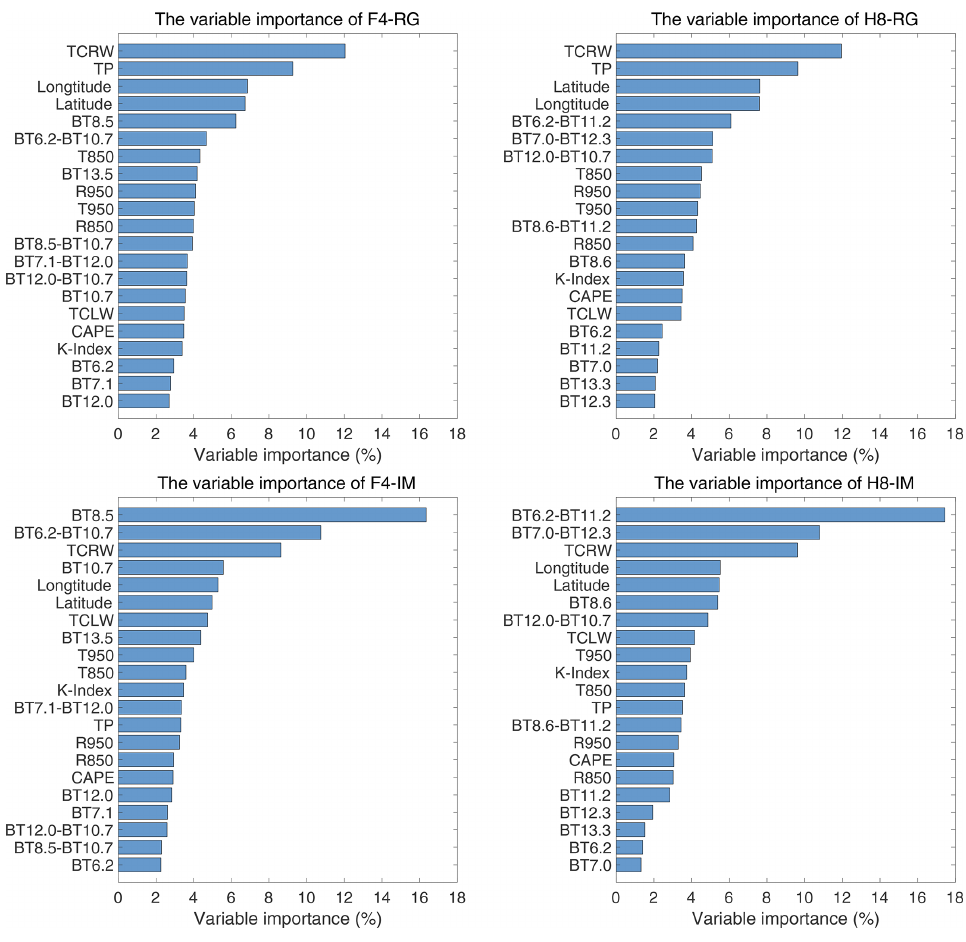
Figure 6. Importance of each variable in the RF algorithm when estimating surface precipitation.